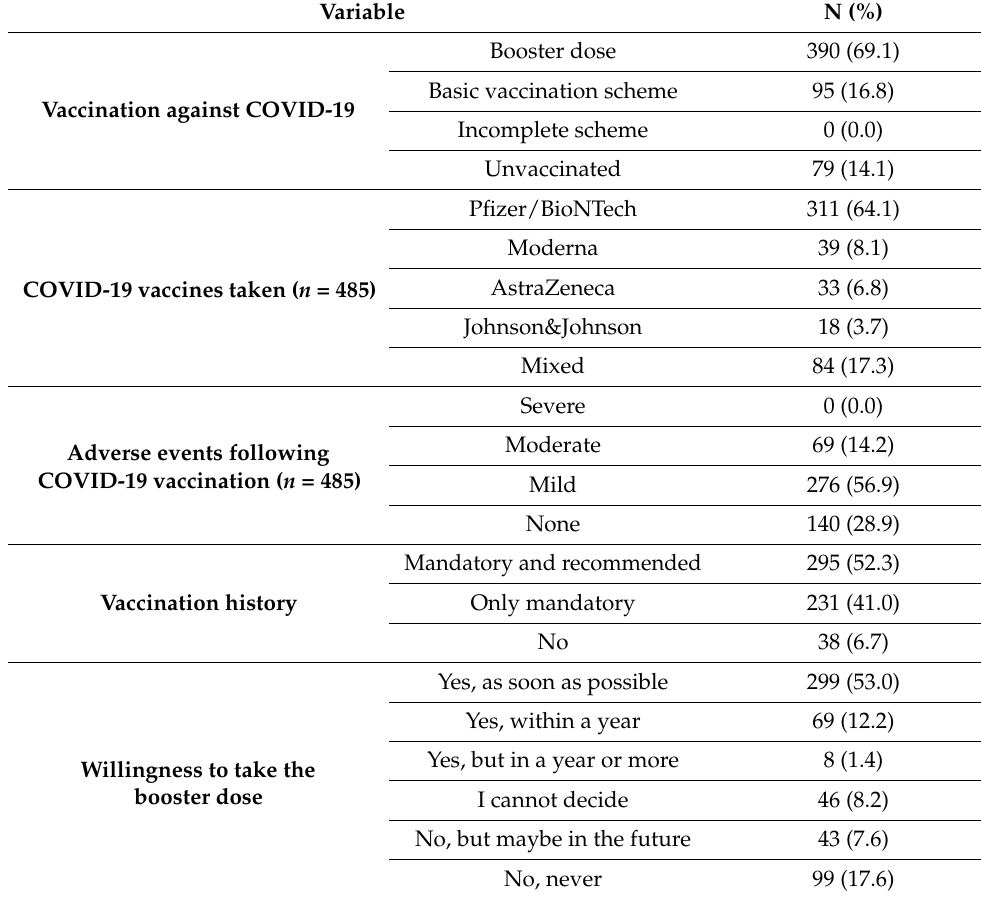
Table 2. Vaccination status and past vaccination history among